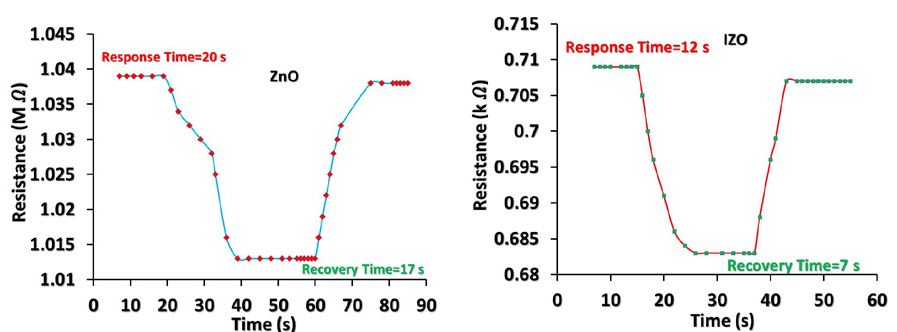
Fig. 4: Brief schematic of the gas sensing device and sensor fabrication. Fig. 4